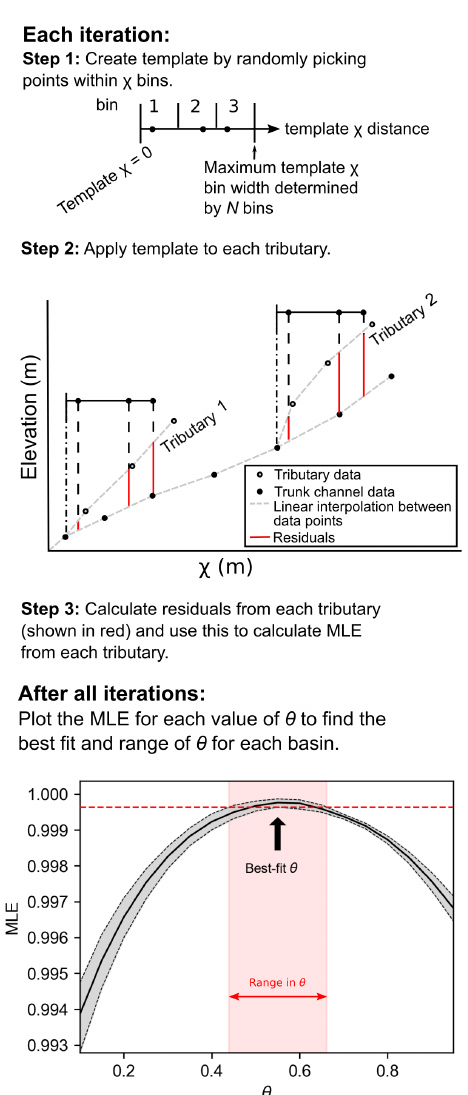
Figure 4. Sketch showing how we compute residuals for our χ bootstrap method of determining the maximum likelihood estimator (MLE) of θ , and then use the uncertainty in MLE values to compute the uncertainty in θ